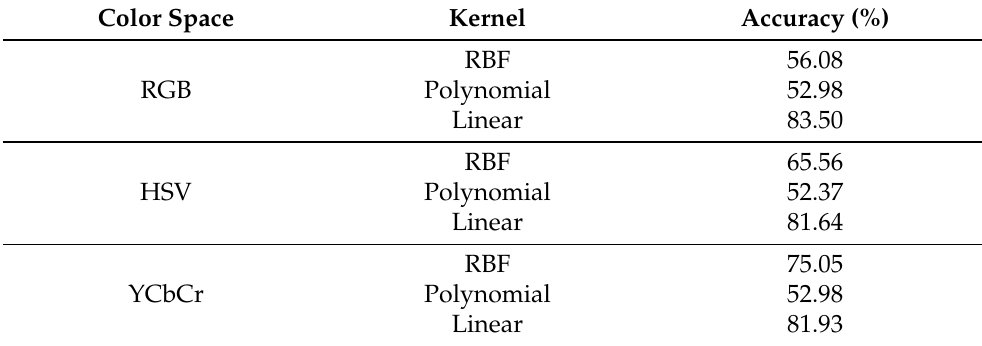
Table 3. Classification result using SVM.